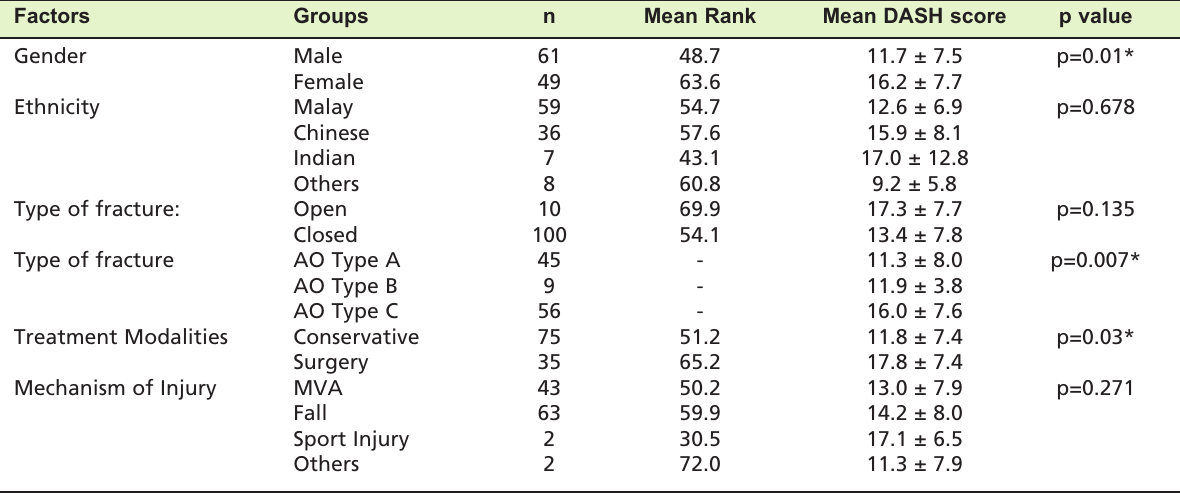
Comparison between different variable with respect to the DASH scores Table II: Factors